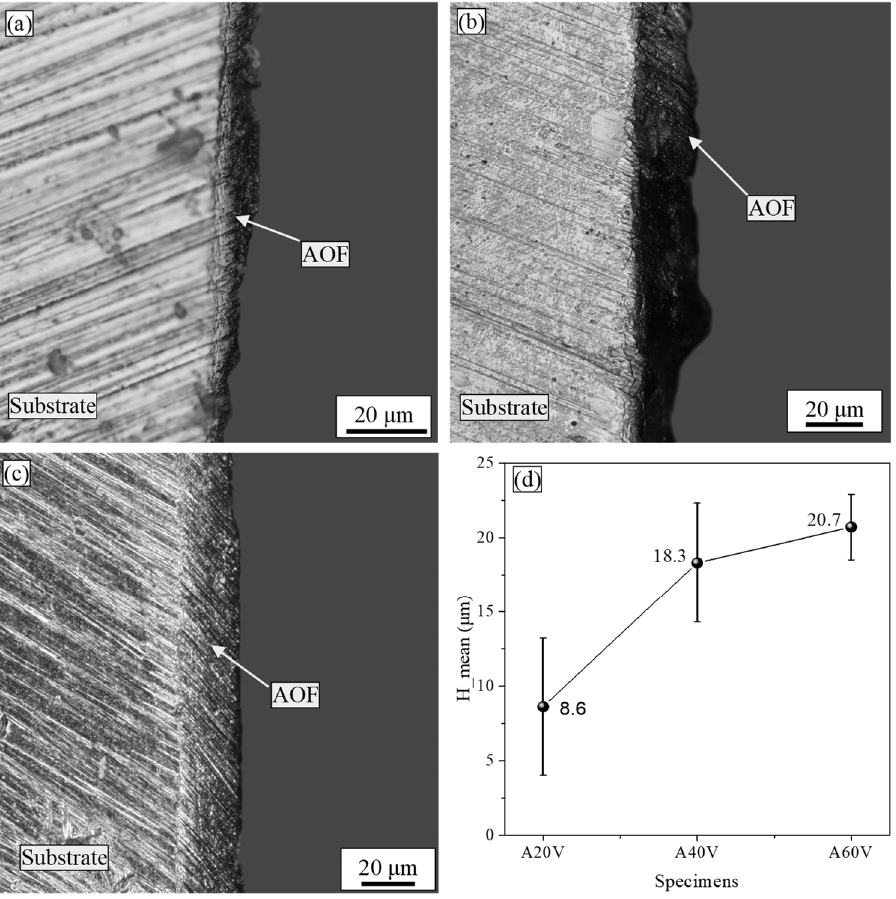
Figure 3. Thickness of the AOF on specimens ( a ) A20V, ( b ) A40V, and ( c ) A60V, and ( d ) H_mean.